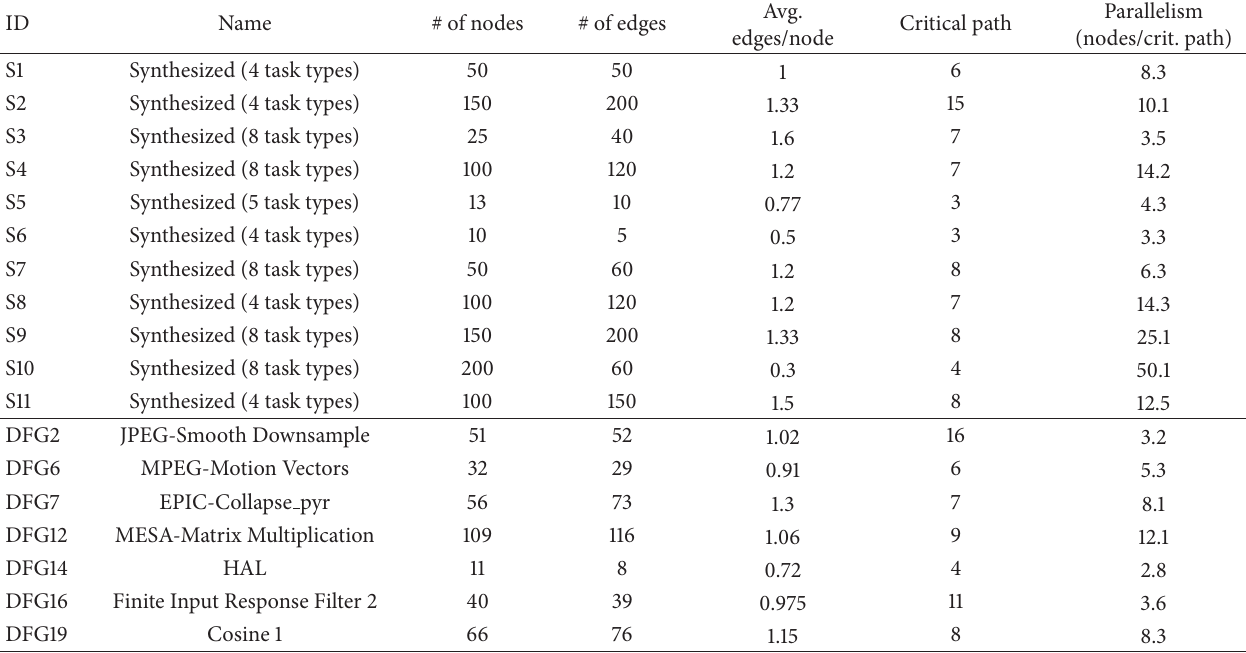
Table 1: Benchmark